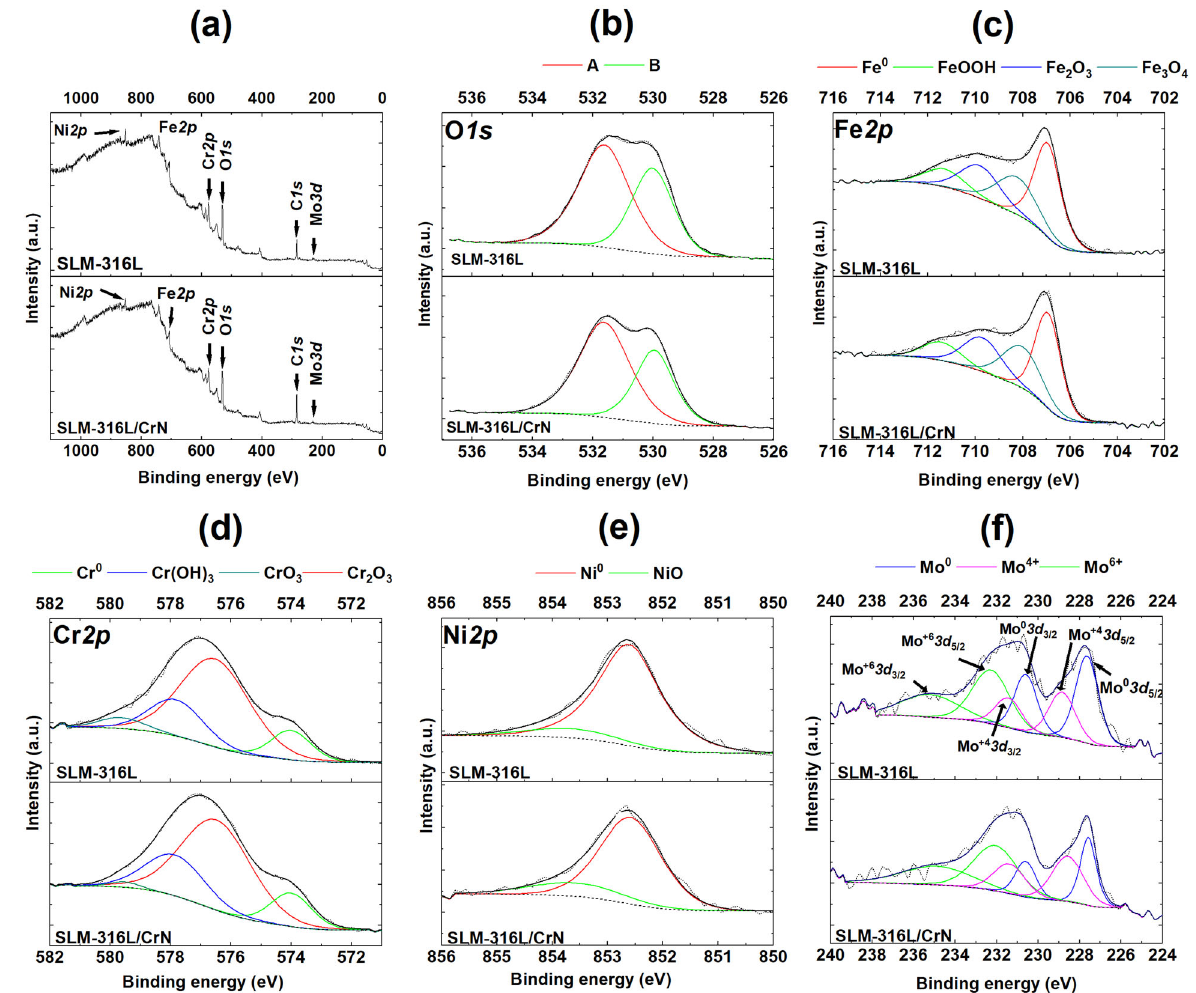
Fig. 7 Passive fi lm characterization using XPS. The high-resolution XPS spectra of ( a ) Survey scan ( b ) O 1s ( c ) Fe 2p 3/2 ( d ) Cr 2p 3/2 ( e ) Ni 2p 3/2 and ( f ) Mo(